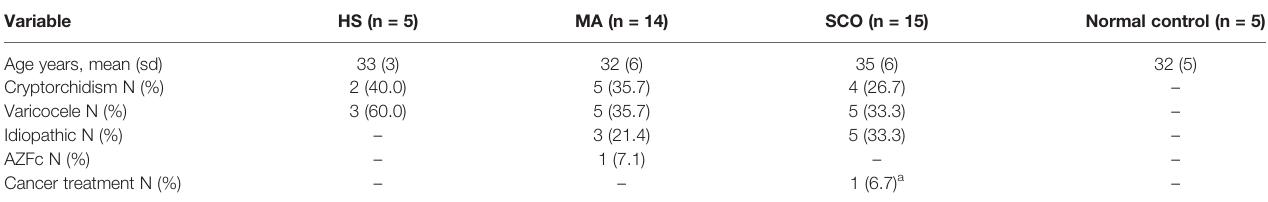
Cancer treatment N